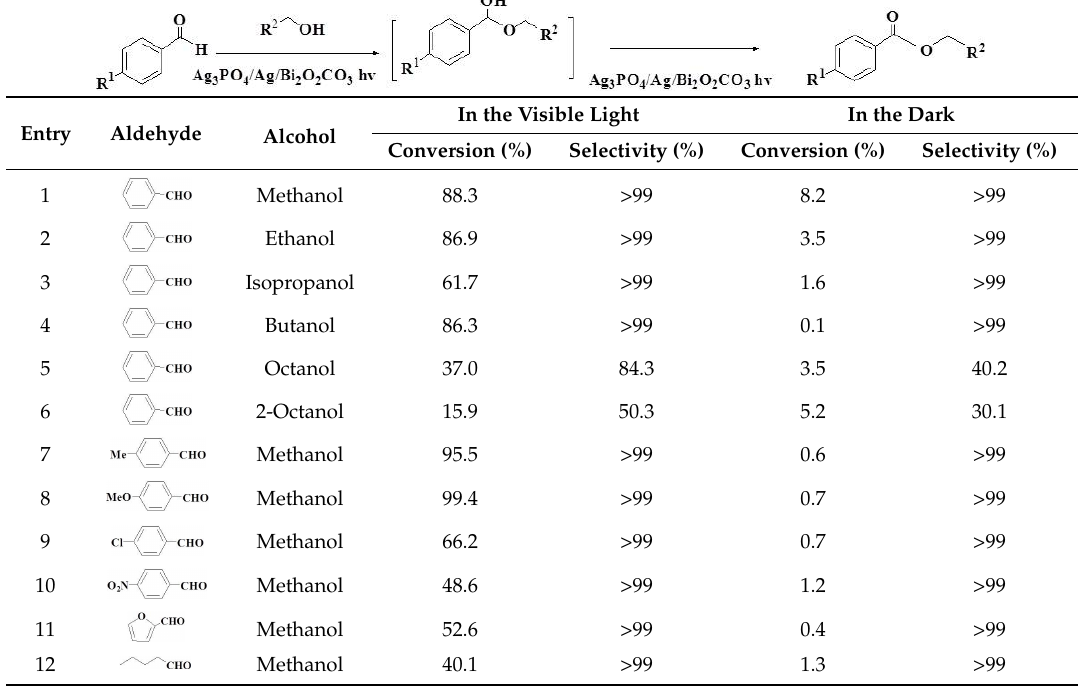
Table 1. Synthesis of esters from different aldehydes and alcohols using 71 wt % Ag 3 PO 4 /Ag/Bi 2 O 2 CO 3 .